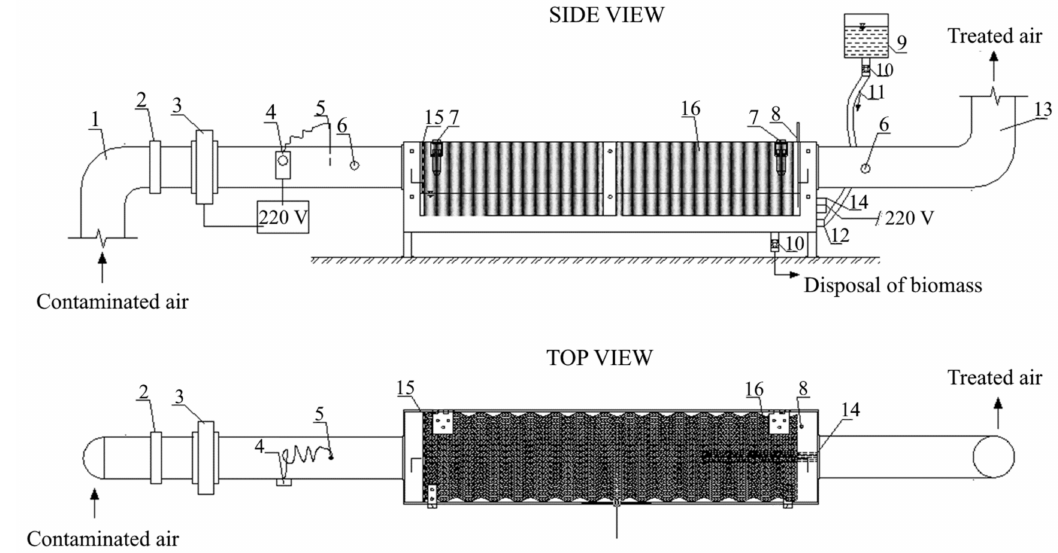
Figure 1. Scheme of the wavy lamellar plate-type biofilter. 1—the inlet duct, 2—a valve, 3—ventilator, 4—a thermostat, 5—a heater with a thermostat, 6—a sampling sites, 7—a fastening element, 8—a temperature sensor, 9—a water tank, 10—a drain valve, 11—a water refill hose, 12—a water inlet valve, 13—the outlet duct, 14—a heating element, 15—the perforated plate, 16—the packing